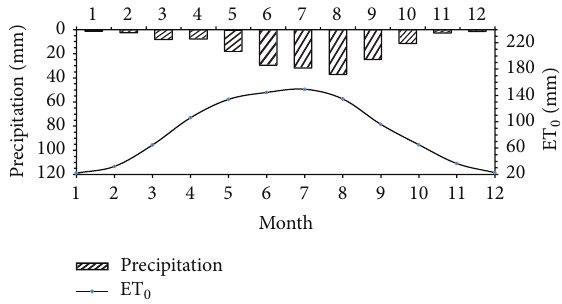
Figure3:ThecomparisonofprecipitationandET 0